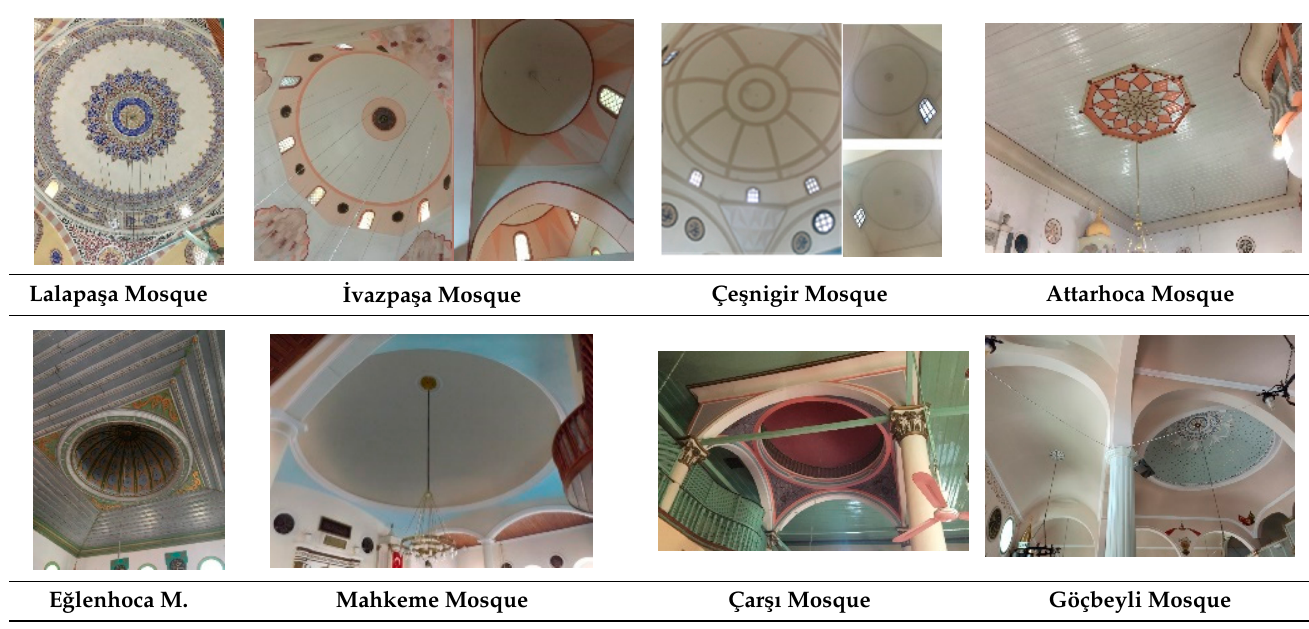
Table 10. The photos from the ceiling structures of eight historical mosques (photos by the authors).